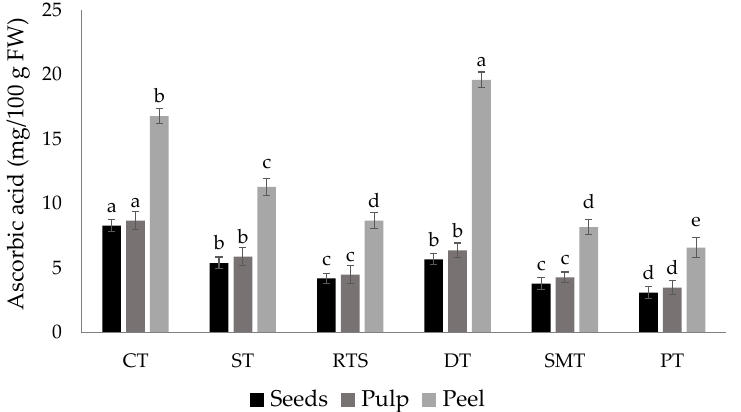
Figure 4. Ascorbic acid content in the seeds, pulp, and peel fractions of each tomato cultivar: Cherry tomato (CT), Smooth round tomato (ST), Round tomato sauce (RTS), Datterino tomato (DT), S. Marzano tomato (SMT), and Piccadilly tomato (PT). The histograms represent mean ± SD. Results were analysed by one-way analysis of variance (ANOVA) followed by Holm-Sidak’s multiple comparisons test. Different letters indicate significant differences within each fraction among different tomato cultivars ( p < 0.001). Table 3. Comparison of lycopene levels among the seeds, pulp, and peel fractions of each cultivar. Cultivar/Fraction Ascorbic Acid